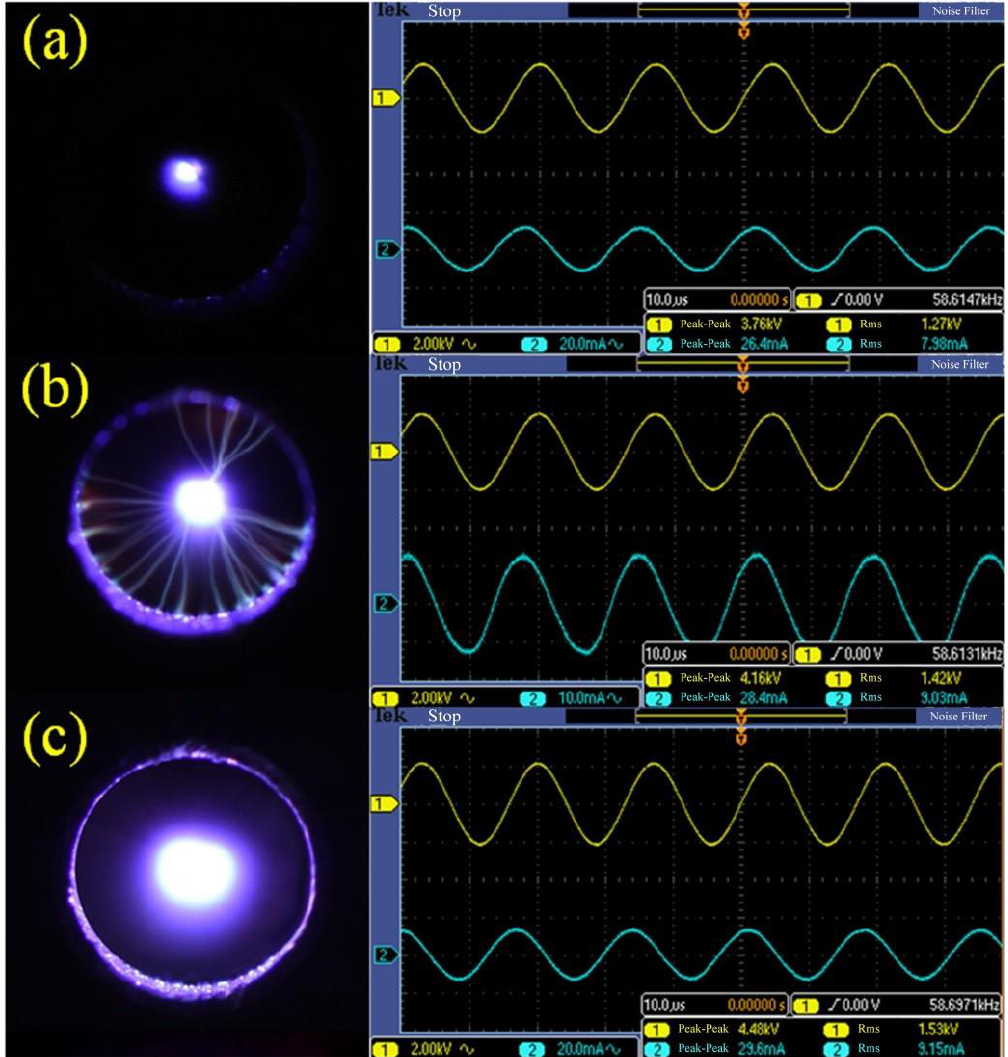
Figure 3. Oscillogram of plasma under di ff erent discharge voltages: ( a ) U = 1.27 kV, ( b ) U = 1.42kV, ( c ) U = 1.53